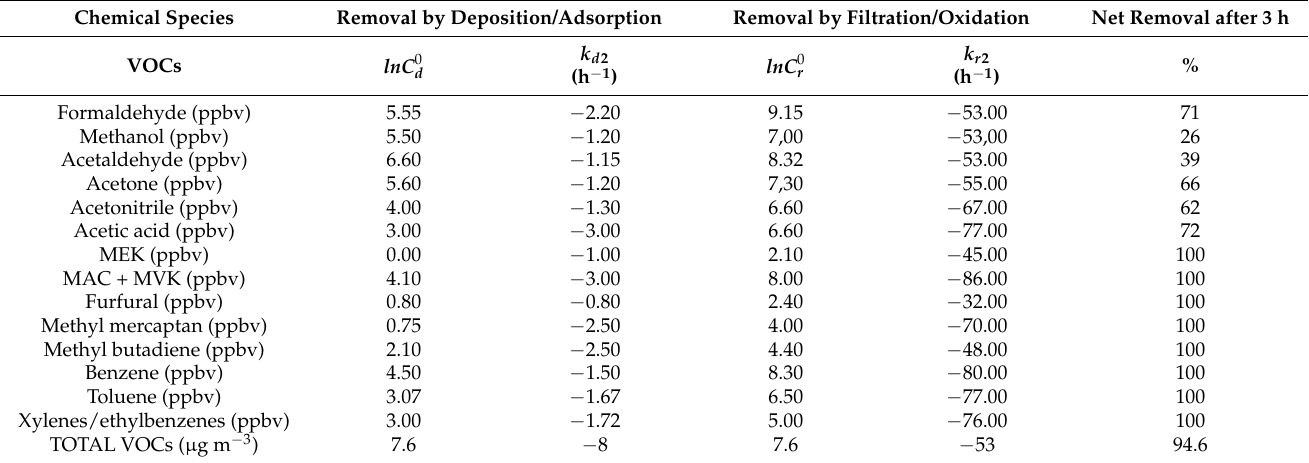
Figure 8. Semi-logarithmic plots of total particle number concentration and PM 2.5 vs. time recorded in the testing room during the experiment performed with diesel emission, using the SANINDOR prototype as air cleaner. The meaning of the lines and symbols are the same as in the previous figures. Values of the slopes and intercepts of the regression lines by natural deposition/adsorption ( d ) and cleaning ( r ), are reported in the figure. They are calculated with respect to t = 0 in the figure. Table 4. Values of the intercepts and slopes of the regression lines obtained in the experiment in Figure 9, performed with diesel exhaust emissions, using the SANINDOOR prototype as an air cleaner. The subscripts d and r have the same meaning as in Tables 2 and 3. In addition to data of individual VOCs obtained by PTR.MS, the total VOCs obtained by a solid-state sensor are also reported, together with the net percent removal measured after 3 h of the system being in